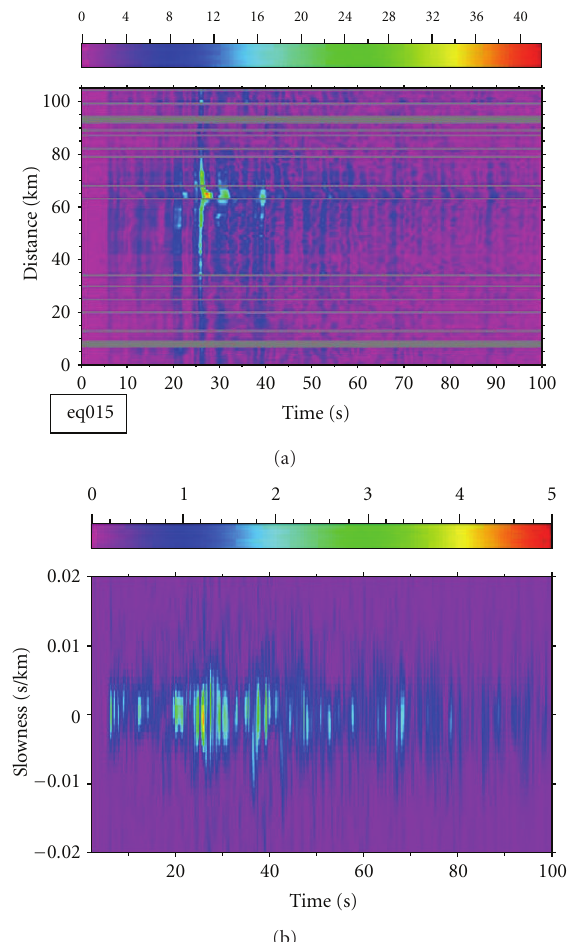
Figure 13: (a) Contour map showing envelope amplitudes of band- pass (1.0–2.0 Hz) filtered traces of the X-phases (event#; eq015). Traces with low signal-to-noise ratios are not used here and are colored in gray. Since the traces here are band-pass filtered, the number of traces with high signal-to-noise ratio is di ff erent from that in Figure 12. Color scale is arbitrarily set to see an apparent amplitude variation within the map. (b) Same as in Figure 7 but for the X-phases (event#; eq015).